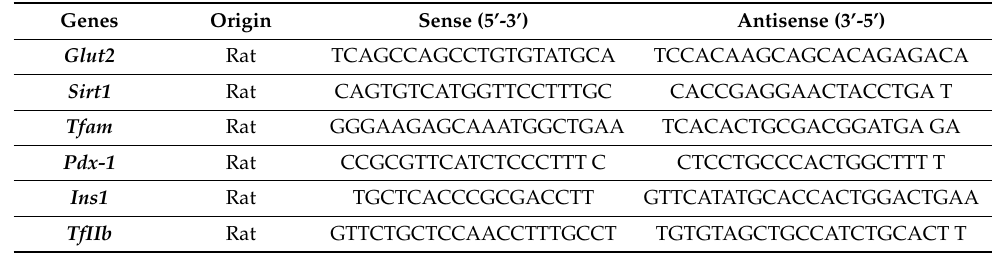
Table 1. List of the genes and primers used for